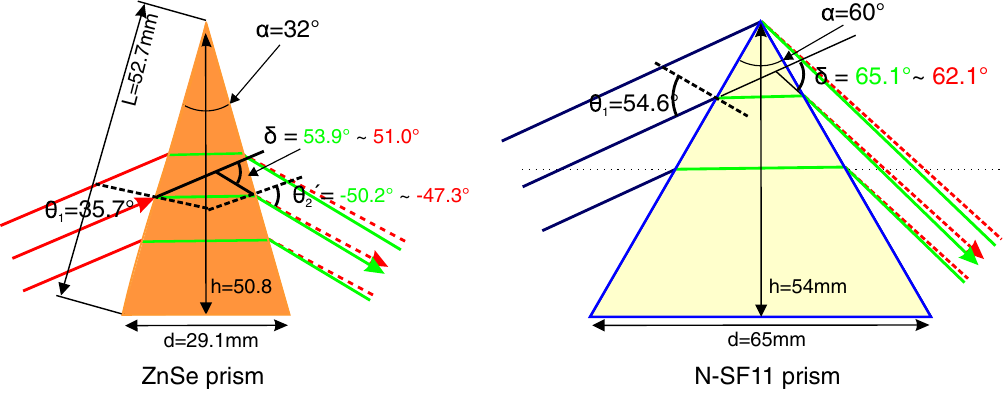
FIG. 7. Illustration of N-SF11 and ZnSe prism geometries, designed for NIR (0.9 to 1 . 7 μ m) and MIR (1.6 to 12 μ m) ranges of the spectrometer,